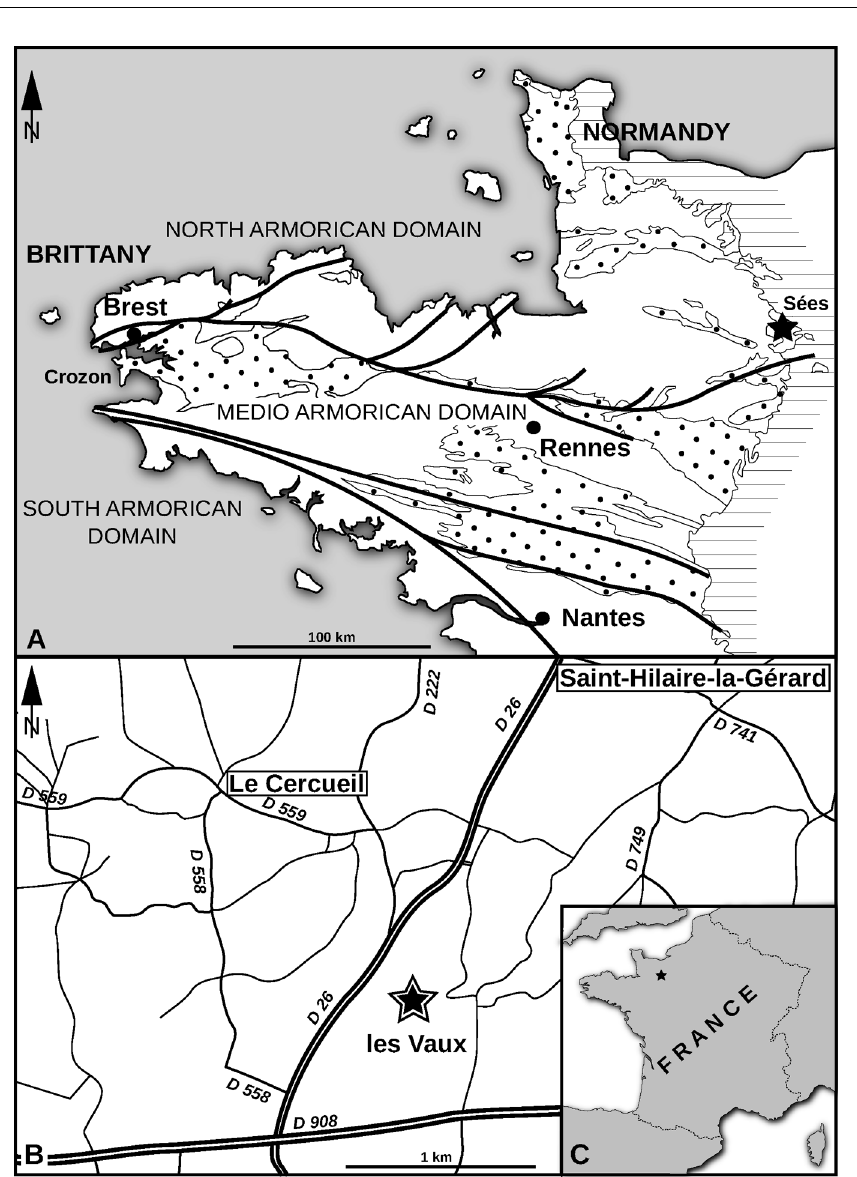
Fig. 1. A , geological sketch of the Armorican Massif (redrawn after Vidal et al. 2011). Stippling indicates Palaeozoic units, horizontal lines represent Mesozoic units, white refers to Proterozoic and Cadomian units and to igneous Variscan units. The black star indicates the investigated outcrop in the SØes syncline. B , C , sketch-map showing the location of the studied section abou t 2 km SW of Saint-Hilaire-la-GØrard (B) and generalized map (C) of the Vaux Limestone locality in Normandy (northern